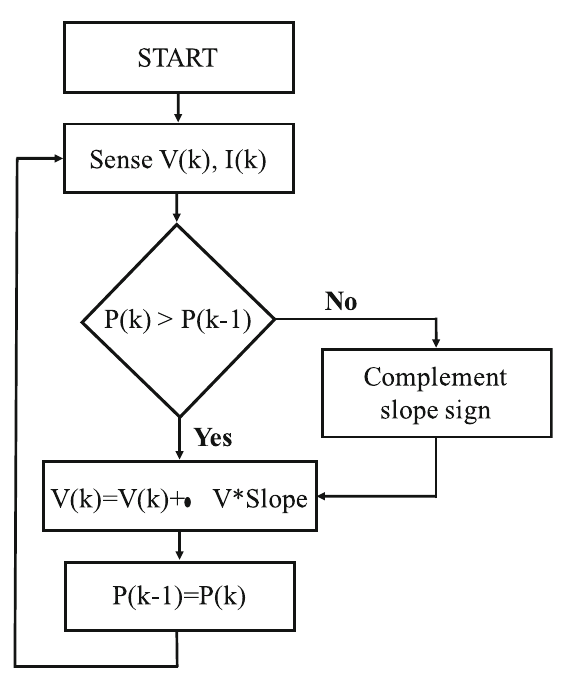
Fig. 4 The flowchart of the P&O-MPPT method